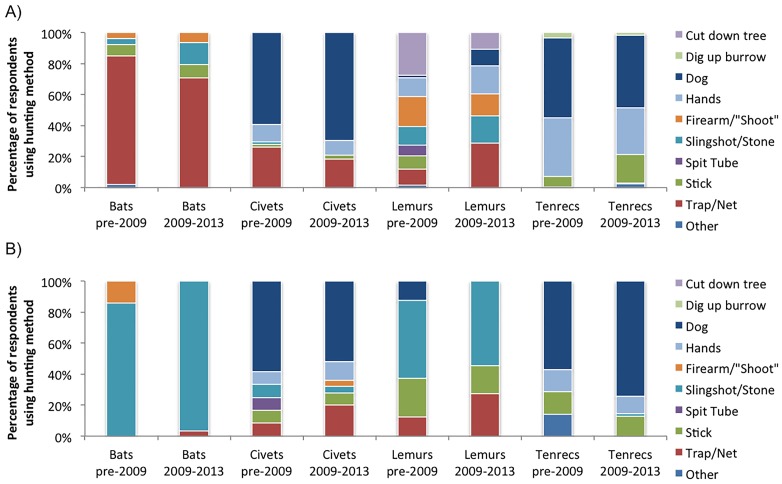
Hunting methods used pre-2009 and between 2009–2013 for (A) urban- and (B) rural hunters (percentages).Data taken from meat consumption interviews. Only animal groups with ≥5 respondents in each time class are presented. Individuals are replicates. Hands = catching with hands by one or multiple people. Trap/Net = includes nets, cable traps, bait with traps. Spit Tube = a blow tube or a device to shoot darts. Stick = includes hitting animal with stick or spearing animal with stick. Individuals are replicates. Other = includes other hunting methods (e.g. fire, using a cross bow).